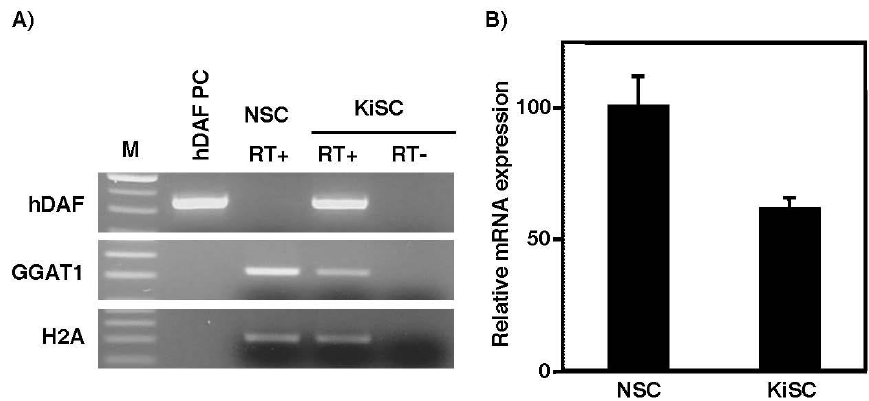
Figure 2. mRNA expression of hDAF and GGTA1 gene in knock-in heterozygous cells. A) hDAF and GGTA1 expression by RT-PCR. Total RNA isolated from normal pig somatic cell (NSC) and knock-in somatic cell (KiSC) were used for cDNA synthesis by reverse transcription and the mRNA expression of hDAF and GGTA1 gene, respectively, were detected with specific primer. hDAF plasmid (hDAF PC) was used as positive control for only detection of hDAF expression. A negative control (RT-) lacking cDNA did not generate an RT-PCR product. M is 100 bp ladder. B) GGTA1 expression in the NSC and KiSC by real-time PCR.